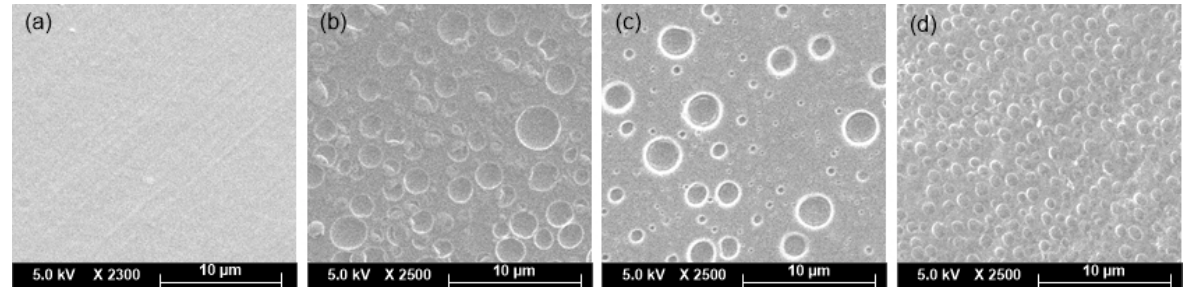
Figure 4. SEM images of ( a ) pCS, ( b ) pCS ‐ 0.4PBLO, ( c ) pCS ‐ 1PBLO, and ( d ) pCS ‐ 1.2PBLO.